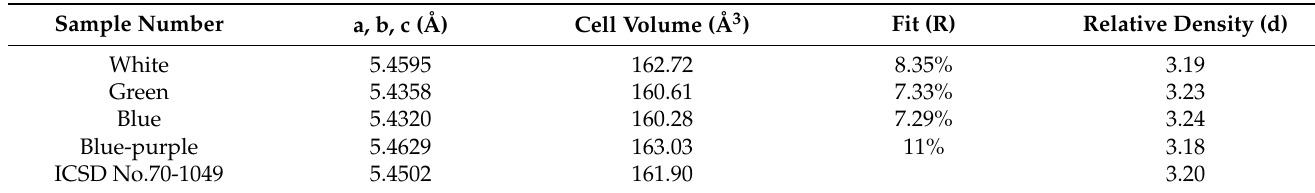
Table 1. Crystal cell parameters of four color fluorite and standard